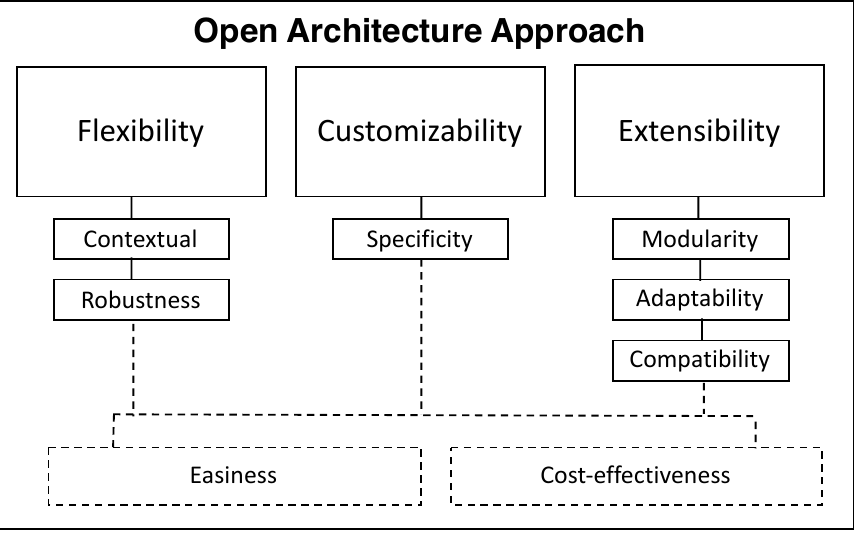
Figure 1. Open Architecture design principles conceptualized, adapted from